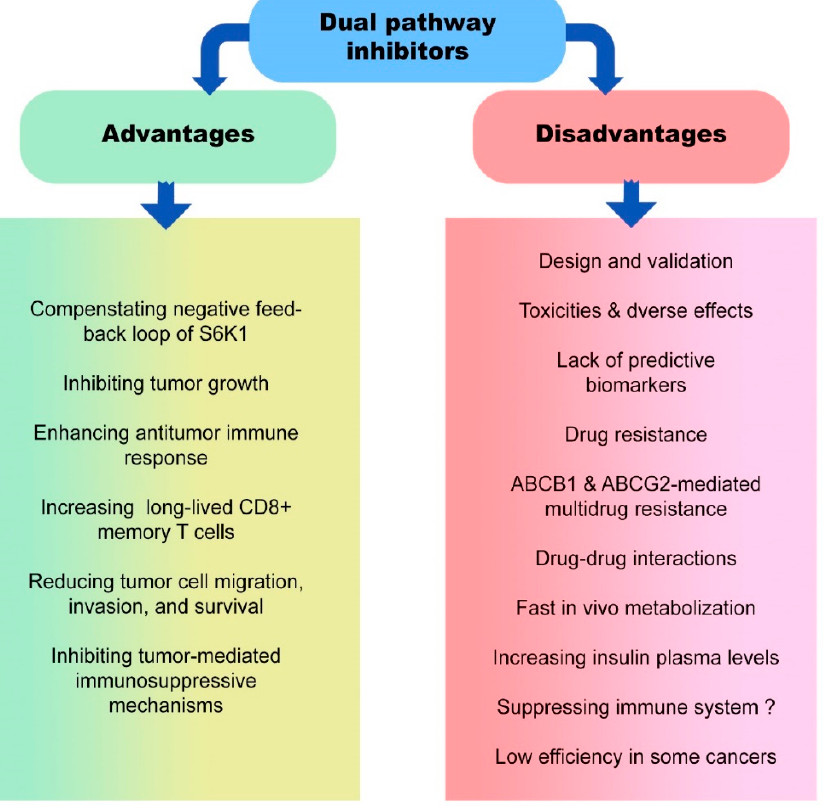
Figure 3. Advantages and disadvantages of using dual pathway inhibitors in cancer therapy.